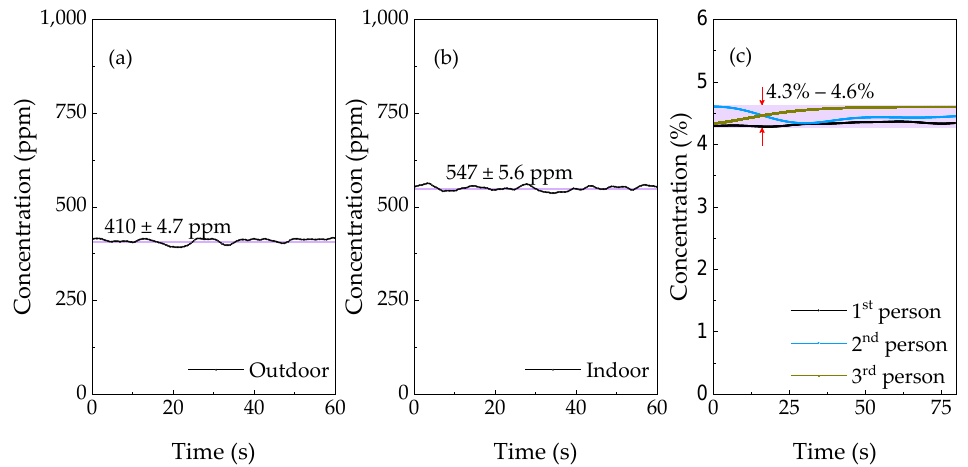
Figure 8. CO 2 measurements of ( a ) outdoor and ( b ) indoor air, and ( c ) expirations of three people.